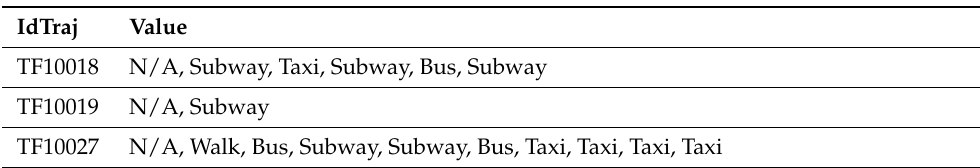
Table 15. Example of transport mean